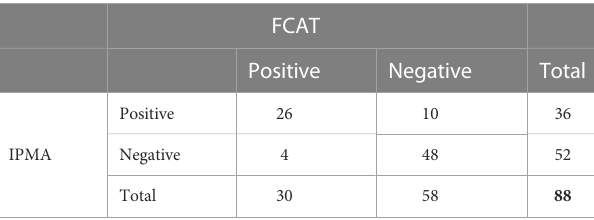
TABLE 4 Matrix used to calculate the Kappa index.